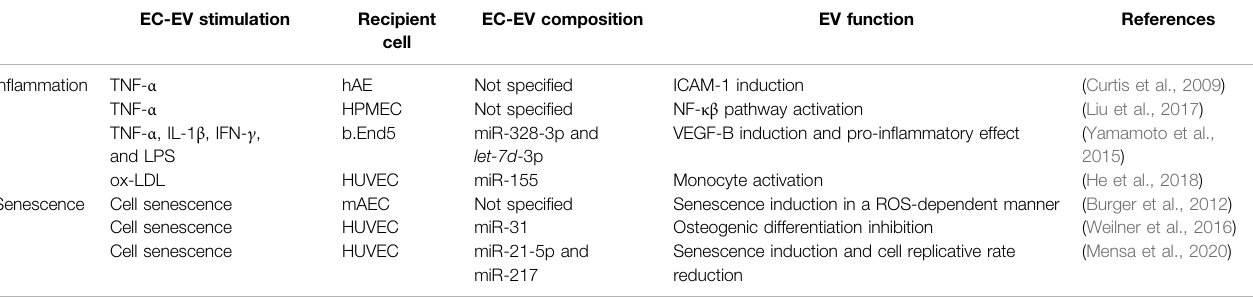
TABLE 1 | Key properties of EC-EVs in the endothelial pathogenesis. EC-EV